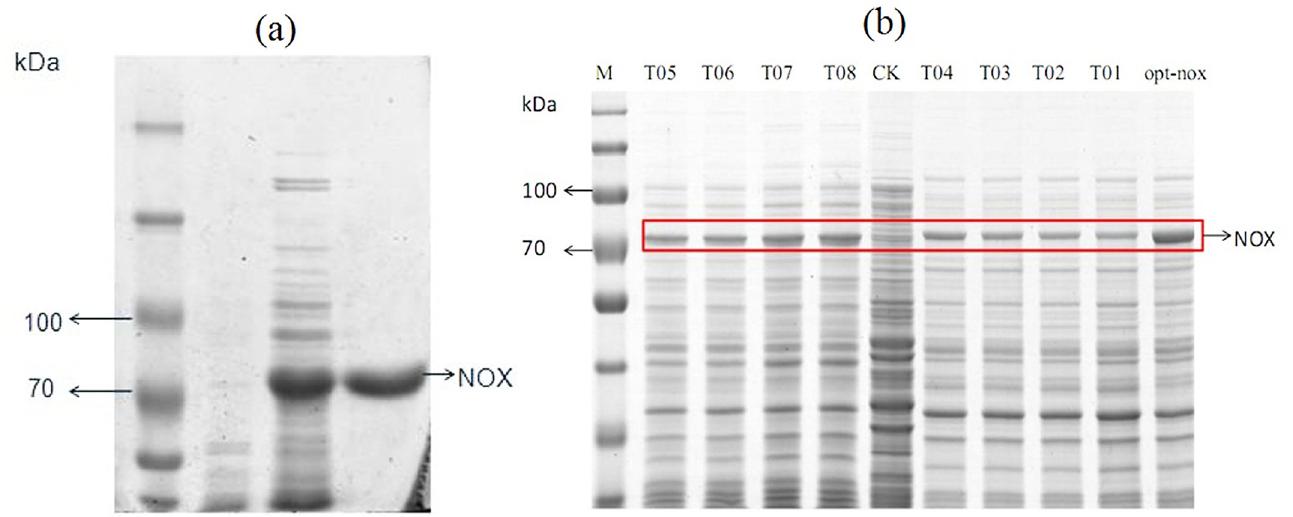
Fig 4. Alignment of wild type nucleotide sequence ( nox ) with the optimized sequence (Nox-opt). Identical residues were highlighted in black background.